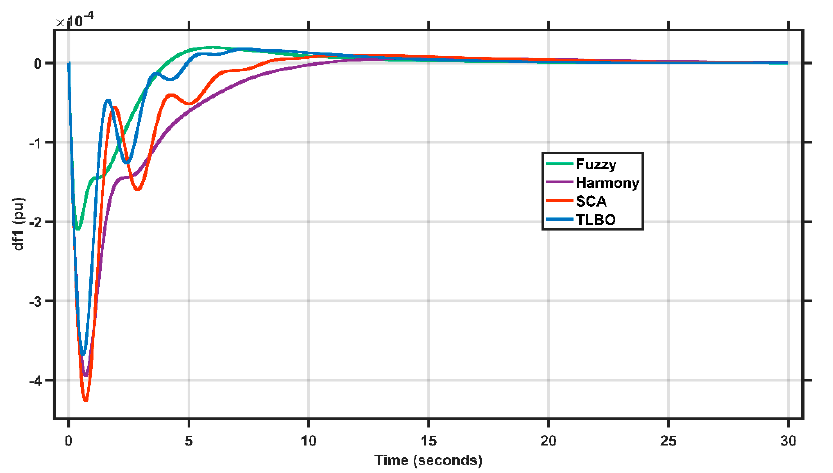
Figure 18. Change in area 1 frequency under 1% load change in area 1.